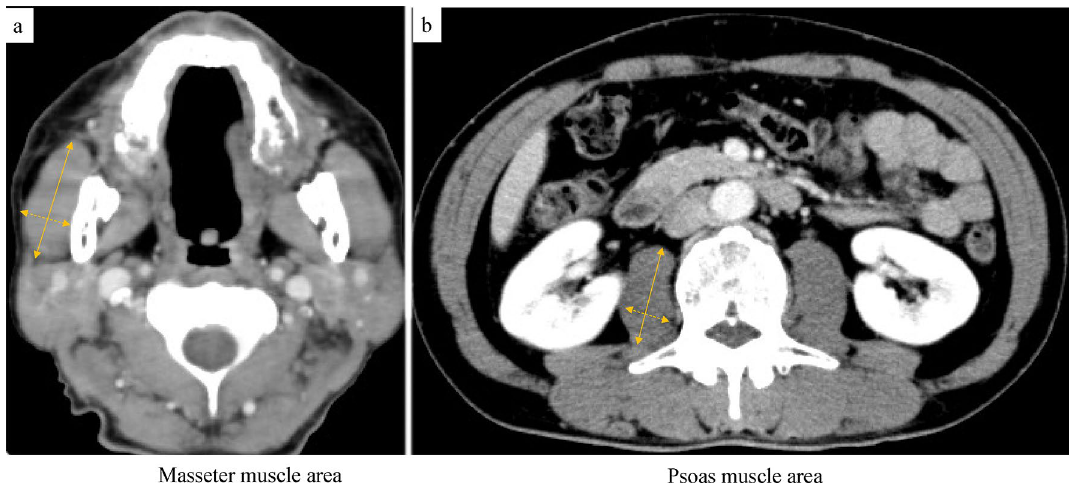
Figure 2. ( a ) The masseter muscle area was calculated 2 cm below the zygomatic arch on the right using the following formula: length of the major axes (continuous line) × the length of the minor axes (dotted line). ( b